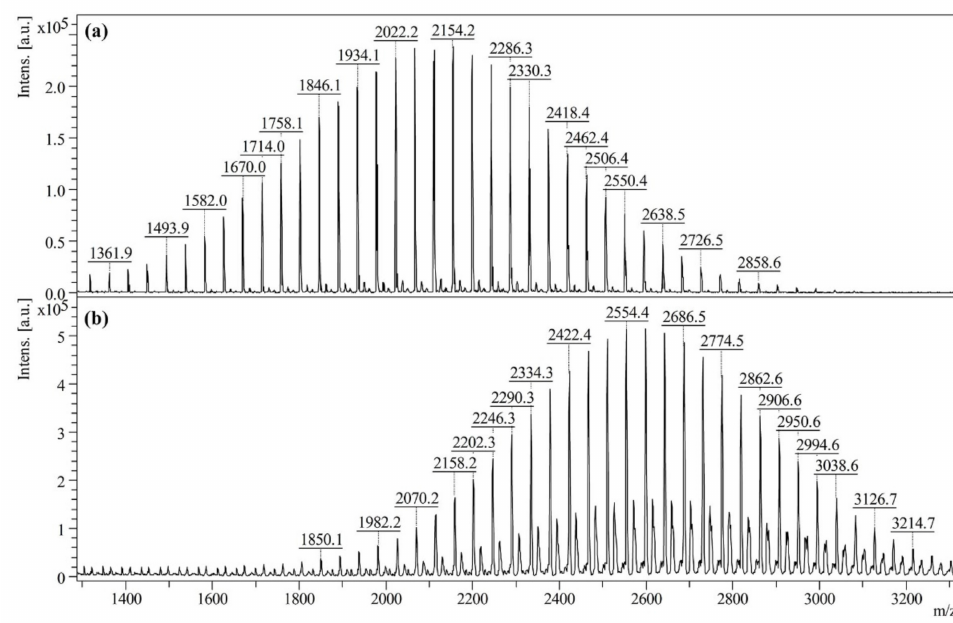
Figure 1. MALDI MS spectra of: ( a ) initial PEG, and ( b ) PEG-(NCO) 2